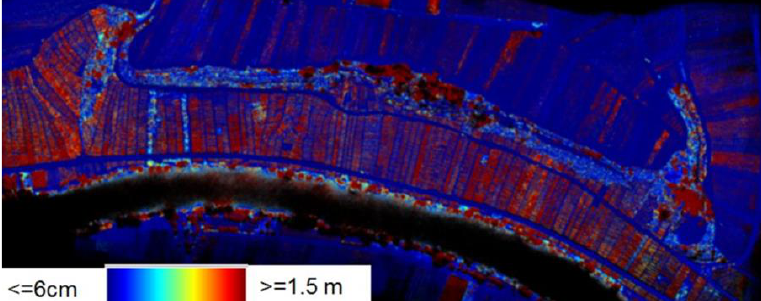
Figure 9: Image textured DSM for the complete test area from Ricoh flight